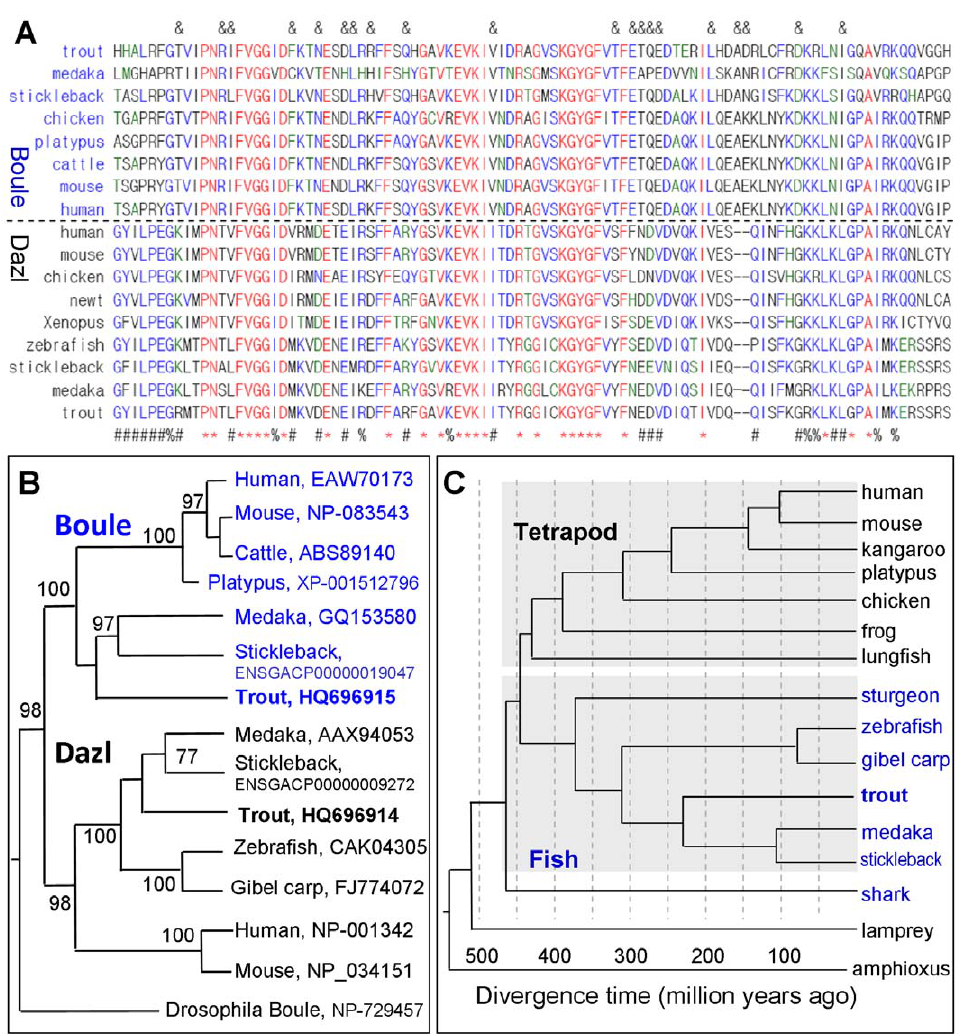
Figure 2. Comparisons of Boule and Dazl proteins between rainbow trout and other organisms. (A) Multiple sequence alignment of the RRM. Boule and Dazl proteins share 16 invariant residues (asterisks) and 13 conserved positions (%). There are 21 invariant or conserved residues characteristic of Boule (&) and Dazl ( # ) proteins each. (B) Phylogenetic tree of DAZ family proteins. The branching between Boule and Dazl coincides with the branching between the fish and tetrapod lineages, and molecular trees on the basis of Boule and Dazl sequences are in accordance with organism relationships, indicating that generation of boule and dazl took place in early vertebrate evolution. Followed species are gene accession numbers. (C) Organism phylogeny and branching times of major fish groups and tetrapod vertebrates. Fish timing is according to [19].